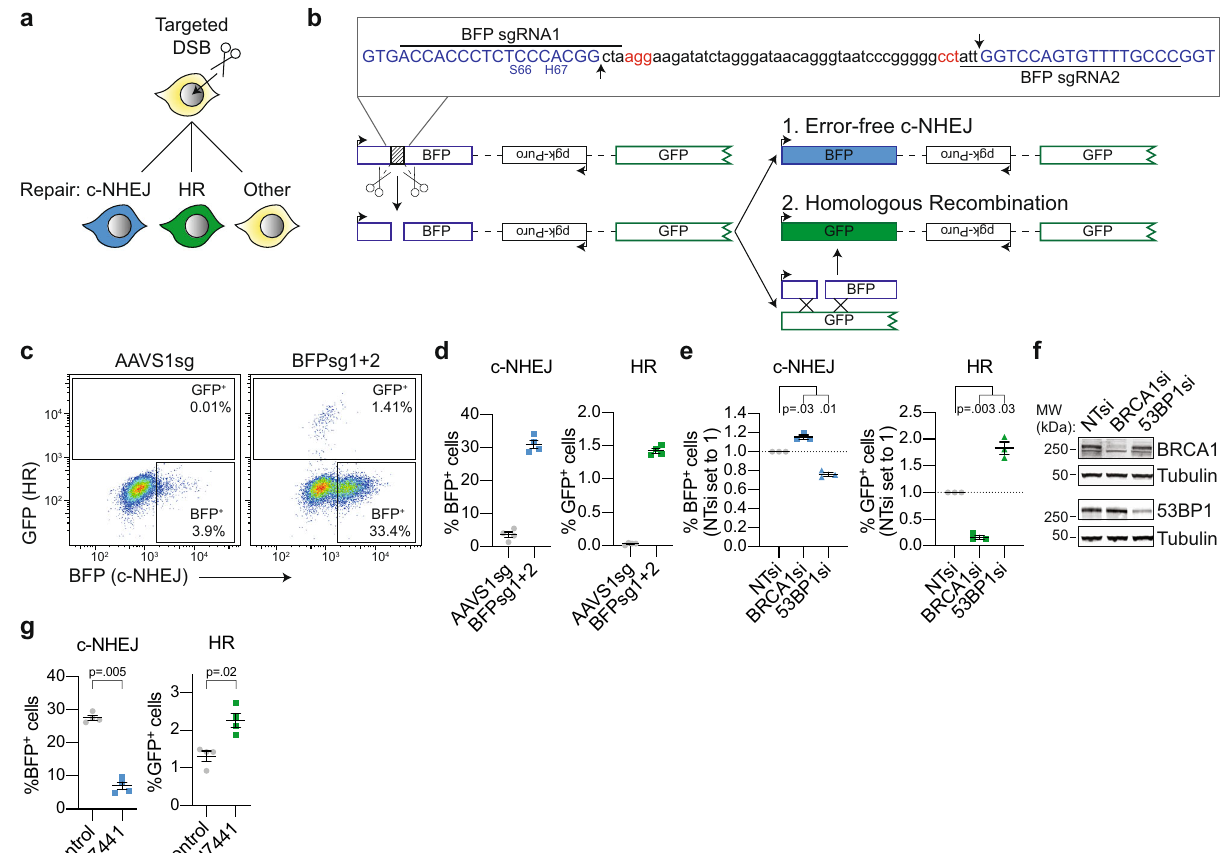
Fig. 1 | DSB-Spectrum_V1 is a reporter for both c-NHEJ and HR. a Cartoon depicting potential outcomes of a multi-pathway reporter cell-line designed to quantify DSB-repair by error-free c-NHEJ and HR. b Diagramatic representation of the genomic DSB-repair reporter construct DSB-Spectrum_V1. Expanded region shows the DNA sequence targeted by Cas9. The sequence of the BFP cDNA is displayedinblue,thePAMsequencesofthesgRNAtargetsitesaredisplayedinred. Arrows in the inset and scissors in the cartoon indicate the Cas9 cut sites. Ligation of the distal DSB ends by error-free c-NHEJ will remove the spacer sequence and restoretheBFPgene. c,d DSB-Spectrum_V1wasintegratedintothegenomeofHEK 293T cells by lentiviral infection, followed by expansion of a single-cell clone. The resulting DSB-Spectrum_V1 cell-line was transfected with Cas9 and an sgRNA tar- getinga controllocus(AAVS1)orBFP,and analyzedby fl owcytometryat72hafter transfection. Panel c shows representative fl ow plots, and panel d shows the